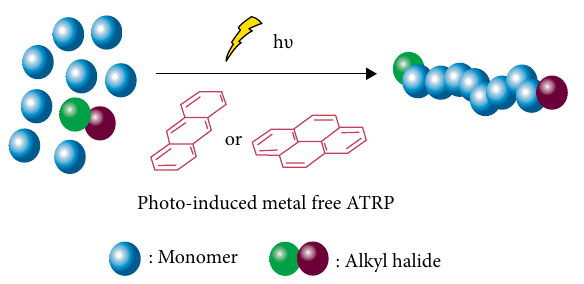
Figure 5: Photoinitiated metal-free controlled/living radical polymerization using polynuclear aromatic hydrocarbons. (Adapted with permission from Ref. [43]).